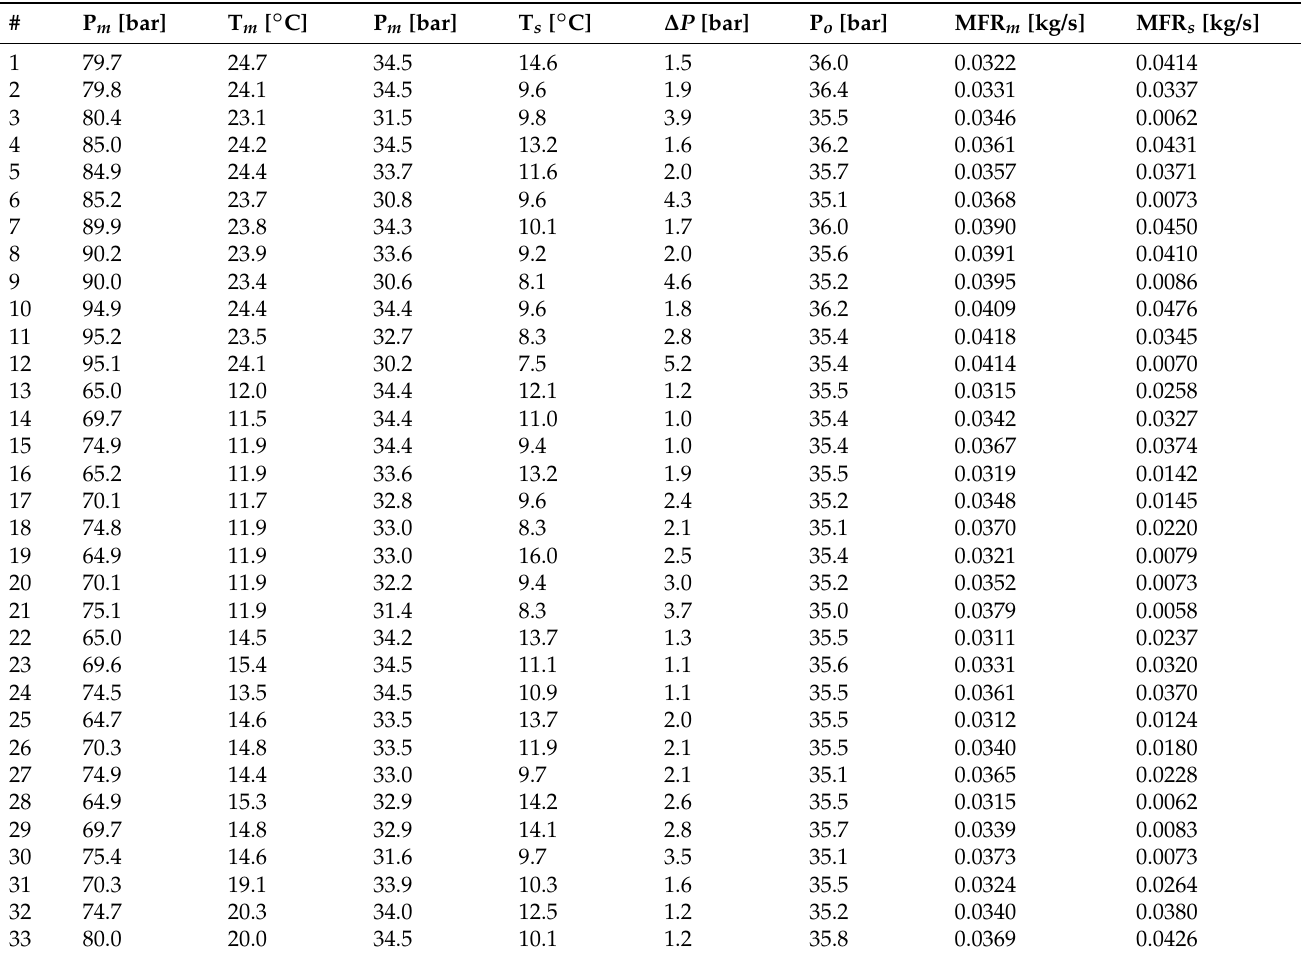
Table A1. Experimental test data at different pressure and temperature operating conditions at the ejector outlet, suction inlet and motive inlet. The datapoints used in the paper (49, 59, 62, 79) are bolded and marked with an